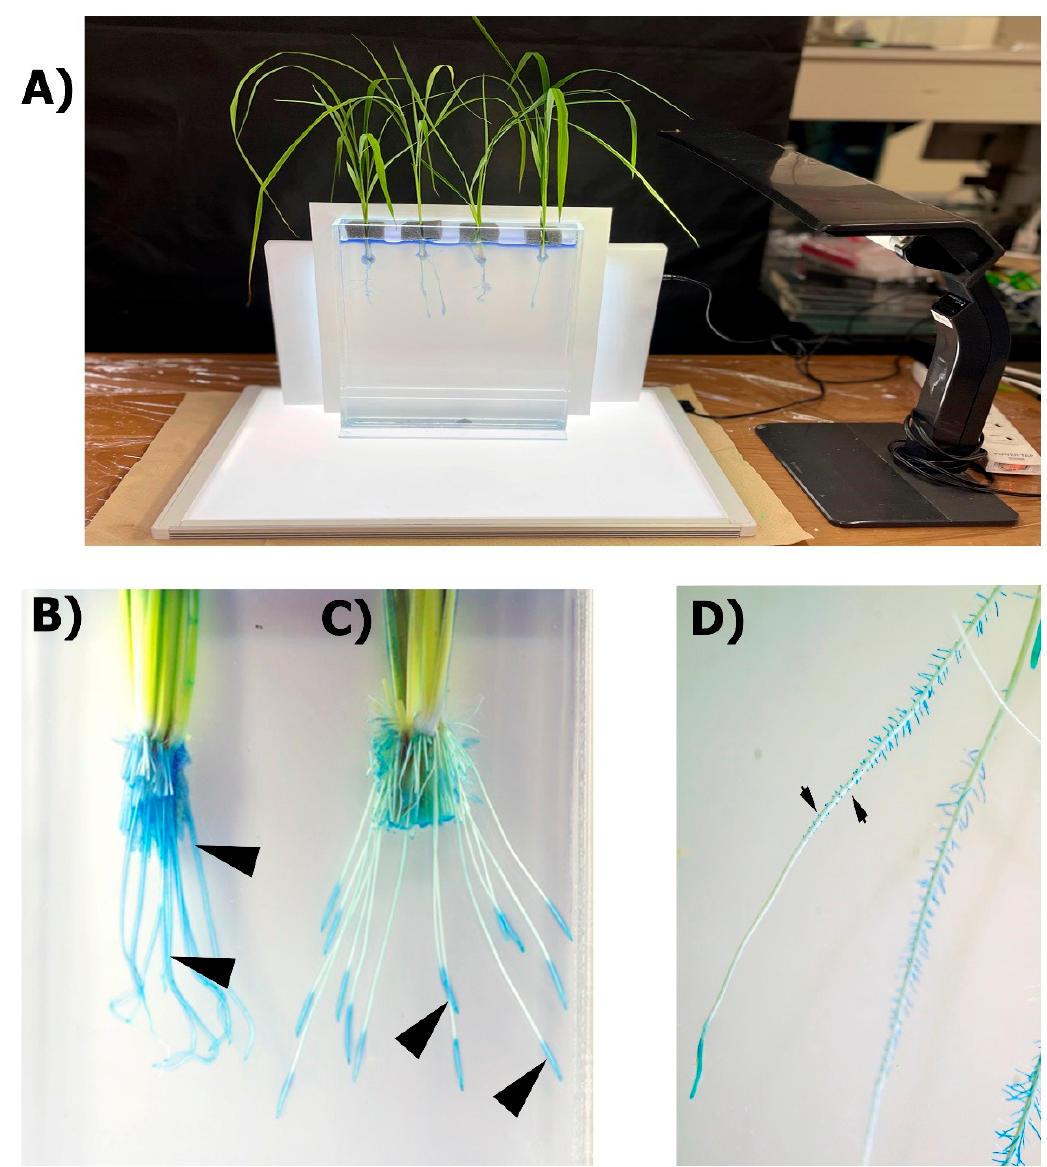
Figure 2. Colorimetric methylene blue method for root radial O 2 loss determination. ( A ) General set-up including photo chamber filled with deoxygenated solution and reduced methylene blue dye. Intact rice plants are inserted and fixed to the photo chamber. Light panels in A are provided to ensure photosynthesis and internal O 2 transport and for enhanced photo collection. ( B ) Rice roots with no barriers to ROL. ( C ) Rice roots with barriers to ROL. ( D ) Sites of O 2 loss through root ‘windows’ of developing laterals (arrows). Rice plants in A and B were grown for 28 days in aerated or stagnant, deoxygenated solutions, respectively. Rice plants in D were grown for one week in aerated solutions with high concentration of Fe (300 µ M). Arrowheads in B and C point to blue halos where O 2 loss is occurring.